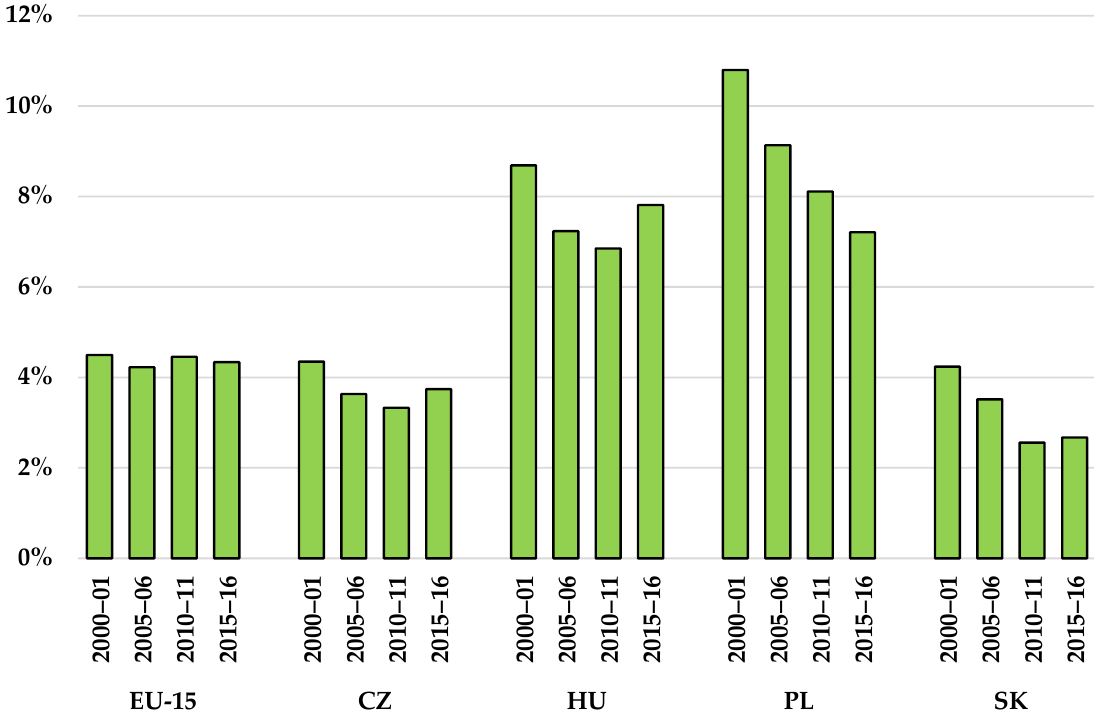
Figure 1. The share of energy consumption in food production systems in total energy consumption by industrial activities. Source: Own calculations based on WIOD Environmental Accounts and WIOD national input–output tables.